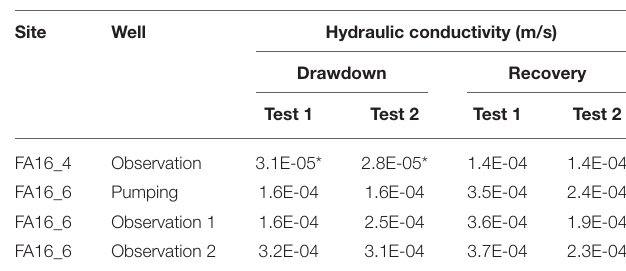
TABLE 4 | Hydraulic conductivity estimates from aquifer tests during drawdown and recovery periods in each